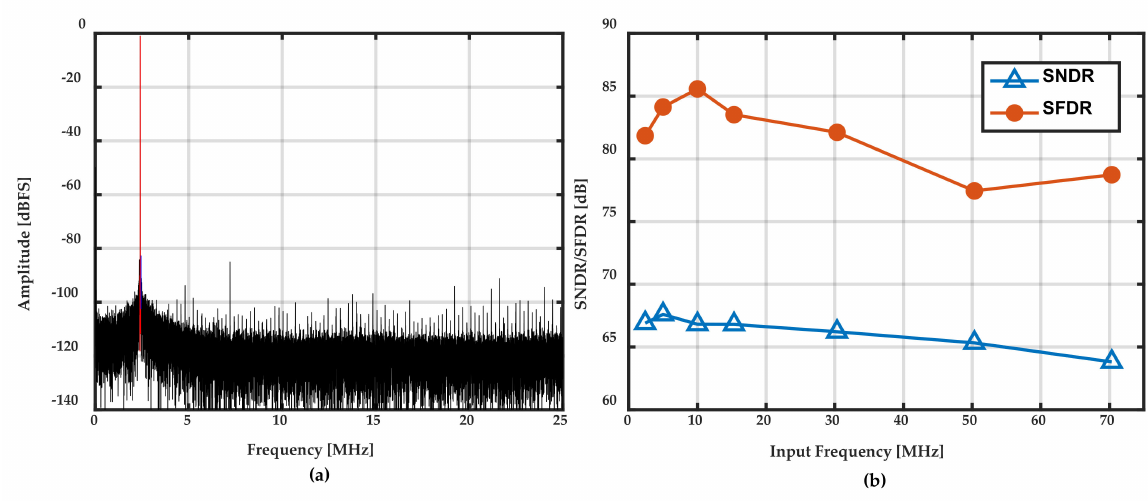
Figure 14. ( a ) Measured output amplitude in the spectrum with 2.4-MHz input, achieving an SFDR of 82.19 dB, and an SNDR of 68.25 dB; ( b ) dynamic performance versus input frequency. The SNDR is drawn in blue and SFDR in red. Used test frequencies are also marked with points and triangles.